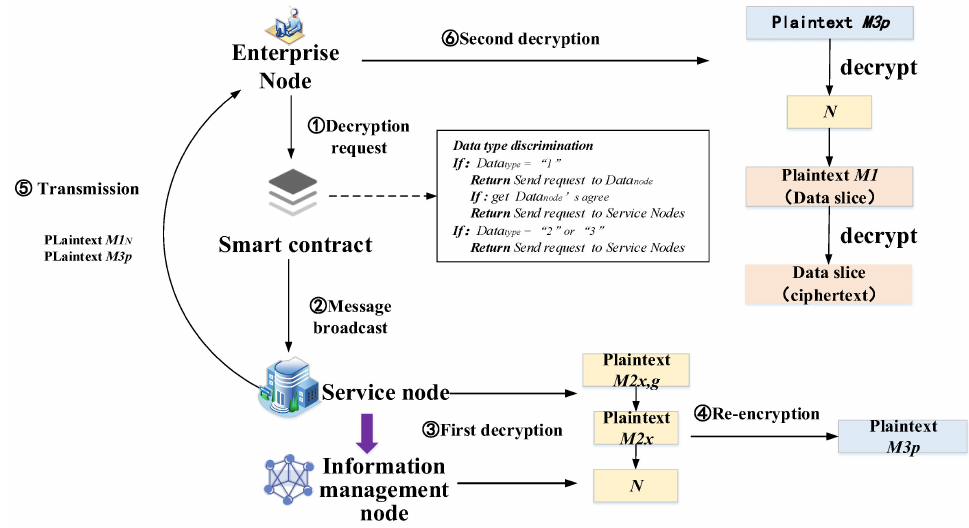
Figure 3. Schematic diagram of multi-party encryption mechanism